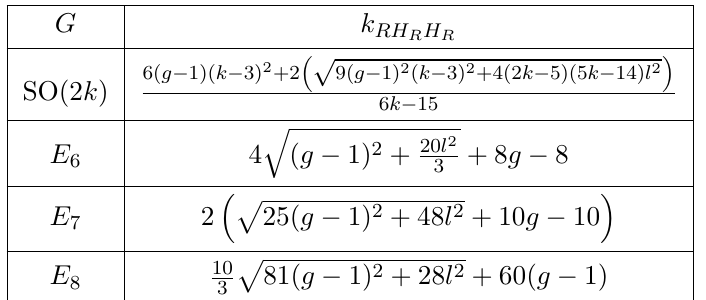
Table 7 . Value of k RH depending on the genus g and the U(1) (cid:13)ux l on (cid:6). R H R G a ( g ) c ( g ) b matter SO(2 k )